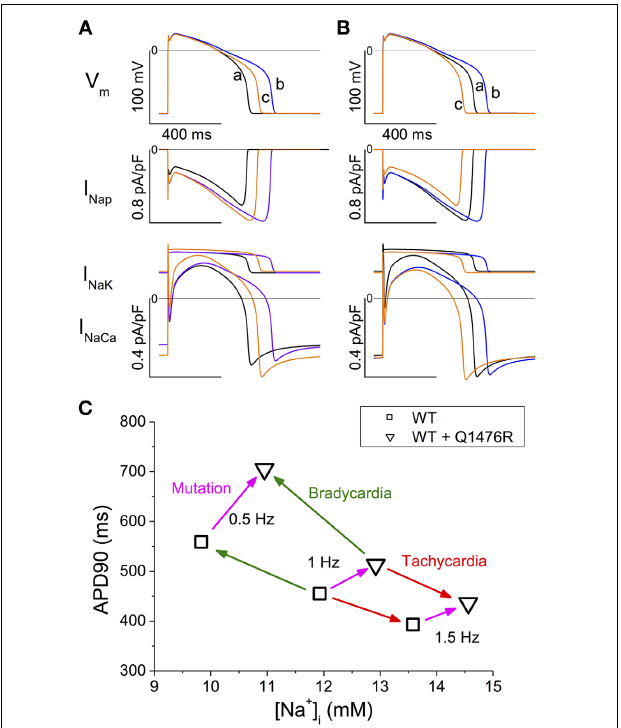
FIGURE 8 | Time course of INaK and INaCa and summary of SS APD 90 and Na i values. (A,B) Analysis of the contribution of INap, INaK, and INaCa to APD 90 changes. ( A) The black traces (a) show the SS AP and currents in WT at 1Hz. The blue traces (b) show the subsequent AP and currents recorded after introducing the heterozygous Q1476R mutation. The orange traces (c) were obtained after reaching the SS. (B) The black traces (a) show AP and currents for the WR model stabilized at 1Hz. The blue traces (b) were obtained when Na i was instantanously set to Na i of the SS WT model. The orange traces (c) were obtained when switching to the WT model. (C) Summary of APD 90 and Na i values at SS at three stimulation frequencies (0.5, 1, and 1.5Hz) and in the WT and WR models. The green arrows indicate the transitions due to bradycardia, the red arrow those due to tachycardia. The magenta arrows indicate the effect of passing from the WT to WR condition at each frequency.